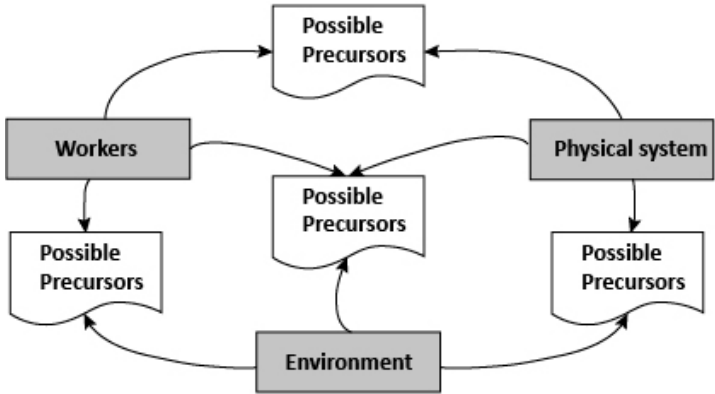
Figure 3. The origination of risk precursors on construction sites.